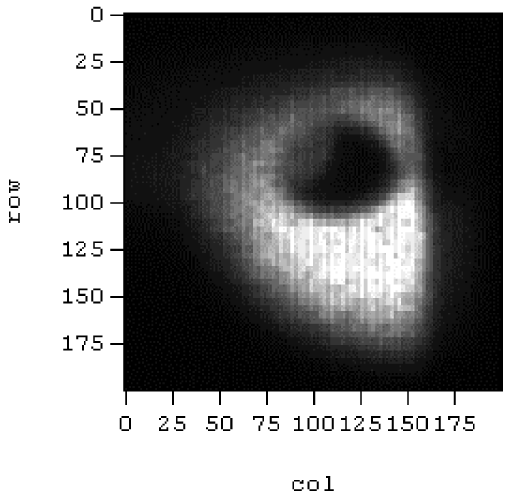
FIG. 3. Deinterlaced image of the electron beam profile with mask